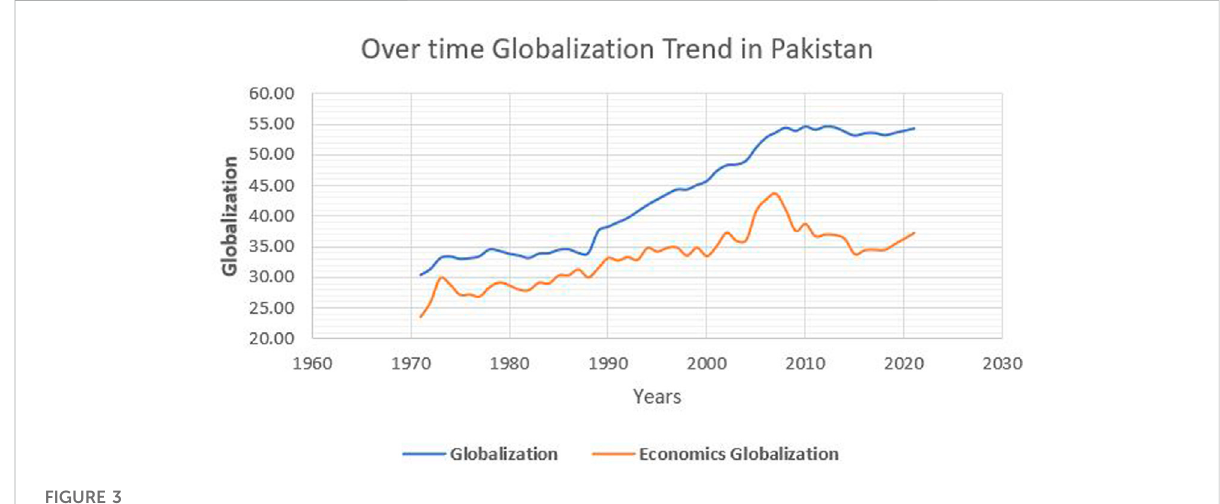
FIGURE 3 Trend of globalization in